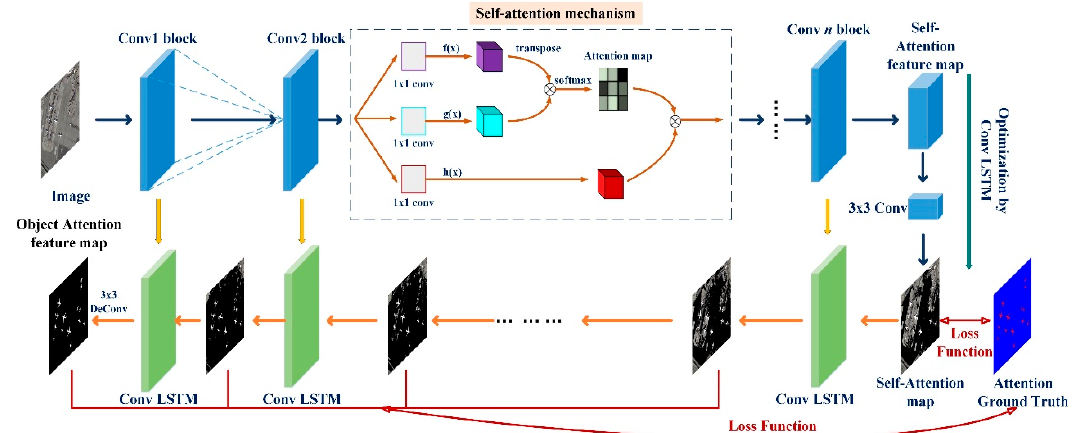
Figure 2. Architecture of our SOSA-Net which integrates the visual saliency detection strategy and introduces the conv-LSTM (long-term and short-term memory) network to optimize the self-attention feature graph, making the model’s attention to the objects in the image more in line with human eyes’ vision.